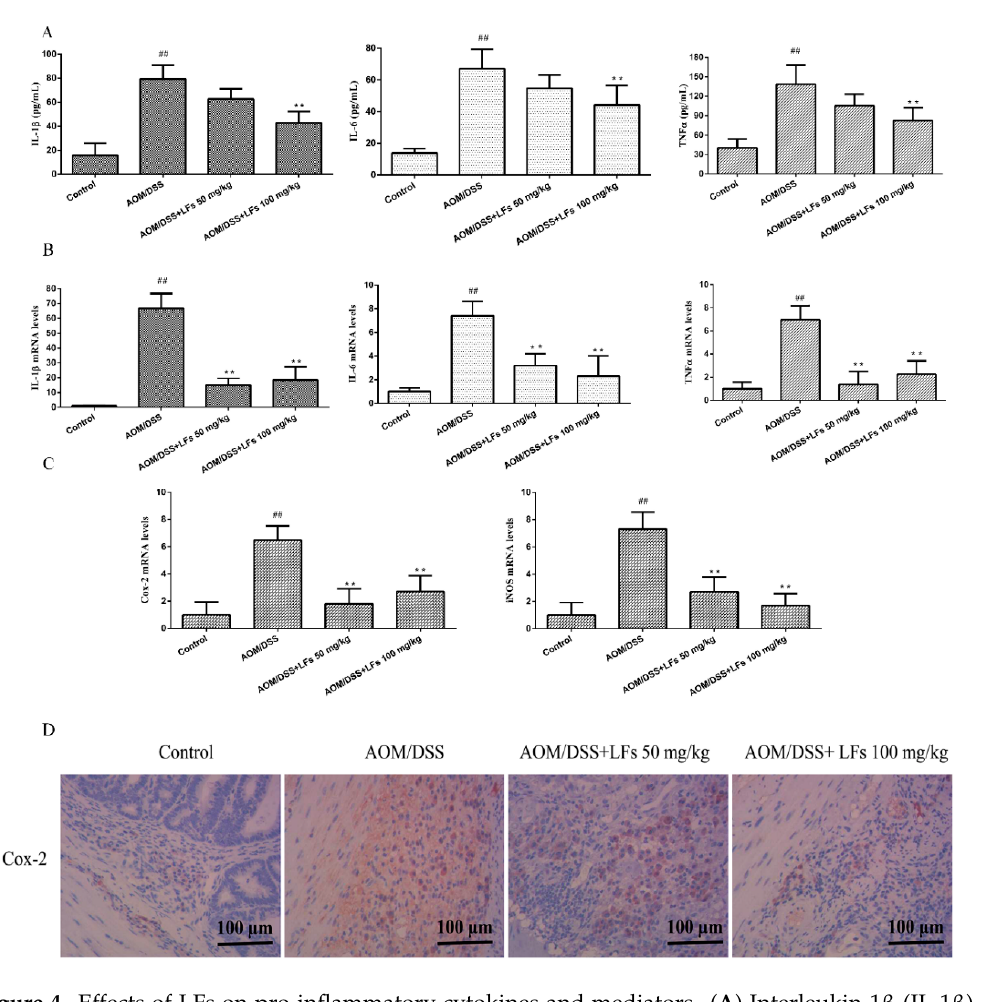
Figure 4. Effects of LFs on pro-inflammatory cytokines and mediators. ( A ) Interleukin-1 β (IL-1 β ), Interleukin-6 (IL-6), and Tumor Necrosis Factor- α (TNF- α ) levels in serum. ELISA kits specific to each cytokine were used to detected levels of IL-1 β , IL-6, and TNF- α in serum. Data are presented as mean ± SD. ** p < 0.01 vs. model, ## p < 0.01 vs. vehicle control; ( B ) mRNA levels of IL-1 β , IL-6, and TNF- α in the colonic tissues. qRT-PCR analysis was carried out to evaluate mRNA levels of IL-1 β , IL-6, and TNF- α . Data are presented as mean ± SD. ** p < 0.01 vs. model, ## p < 0.01 vs. vehicle control; ( C ) mRNA levels of cyclooxygenase-2 (Cox-2) and inducible nitric oxide synthase (iNOS) in the colonic tissues by qRT-PCR analysis. Data are presented as mean ± SD. ** p < 0.01 vs. model, ## p < 0.01 vs. vehicle control. ( D ) Immunohistochemical staining of Cox-2 in colonic tissues.